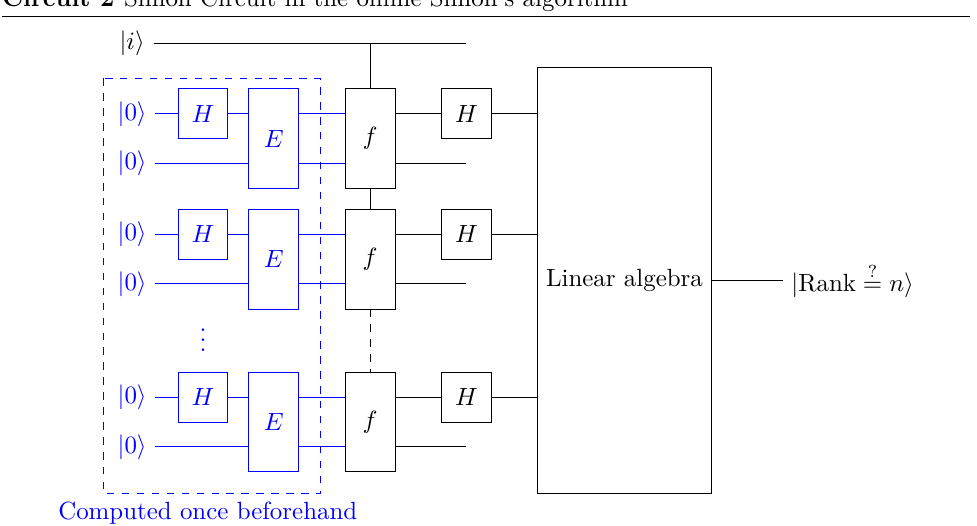
Circuit 2 Simon Circuit in the offline Simon’s algorithm